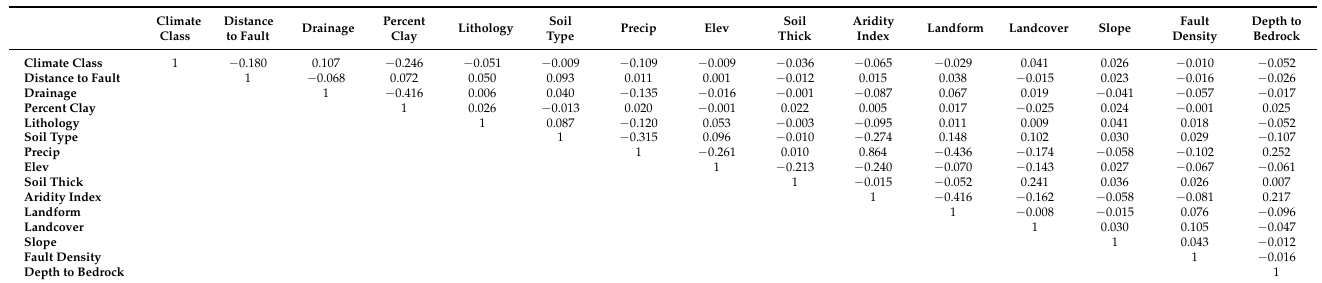
(Table 2). Analysis of the predisposing factor contributions, from a Maximum Entropy model of the original 99 events, resulted in precipitation, fault density, and soil with the highest relative contributions at 42%, 27.6%, and 8.6%, respectively. Thus, for purposes of this study, the location uncertainty impact is analyzed and demonstrated for only these three factors. A fault density derivative dataset was developed with the ArcGIS “Line Density” tool and the active faults from the GEM Global Active Faults database [33], utilizing a search radius of 250 km and an output cell size of 25 sq km. The new dataset represents the fault length (km) per square kilometers of area. Table 2. Matrix of environmental factor correlation